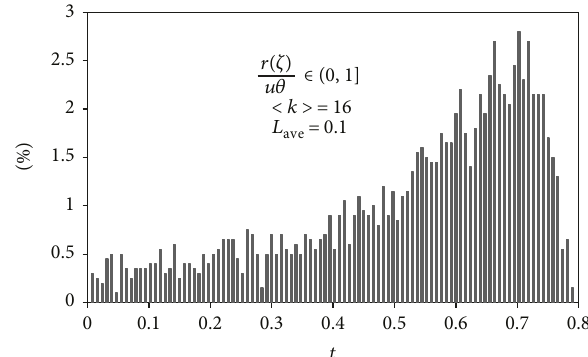
Figure 11: The infection distribution of individuals when y randomly selected in 0, 1 .